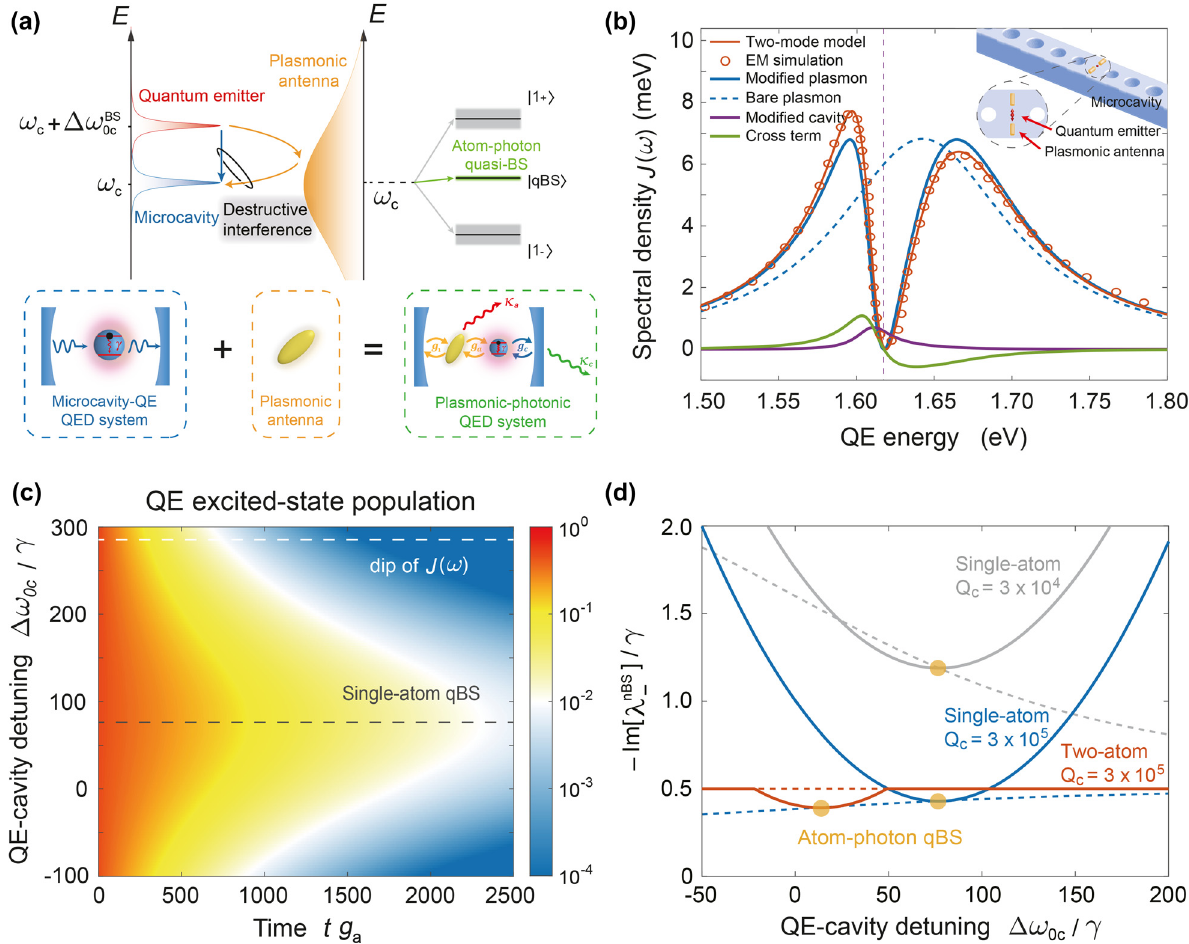
Figure 1: Atom-photon qBS in a hybrid plasmonic-photonic cavity QED system. (a) Concept diagram of atom-photon qBS in hybrid cavity. The atom-photon qBS occurs due to the destructive interference between two coupling channels belonging to QE and photonic microcavity, which do not need to overlap. The resultant eigenenergy spectrum at the single-excitation subspace has triplet sublevels. (b) Application of the two-mode model to calculate the spectral density J ( 𝜔 ) and identify different components in a sample hybrid cavity QED system [4], where a QE with dipole moment 𝜇 = 60 D at the gap center of a plasmonic antenna is placed on top of a dielectric nanobeam (inset). The vertical dashed line indicates the bare cavity resonance 𝜔 𝜅 = 5.4 μ eV. (c) Relaxation dynamics of an initially excited QE (i.e., the color-map represents the excited-state population c , with QE’s decay rate 𝛾 = 10 μ eV. The white and gray dashed lines indicate the the hybrid cavity as the function of QE-cavity detuning Δ 𝜔 0c dip of J ( 𝜔 ) and the optimal Δ 𝜔 corresponding to single-atom qBS, respectively. (d) The imaginary part of the calculated eigenenergy 0c for single-atom and two-atom cases at the different microcavity quality factors corresponding to atom-photon qBS as a function of the Δ 𝜔 0c Q c , while those of bare microcavity are also shown for comparison (dashed lines with the same color). The yellow dots label the conditions of the atom-photon